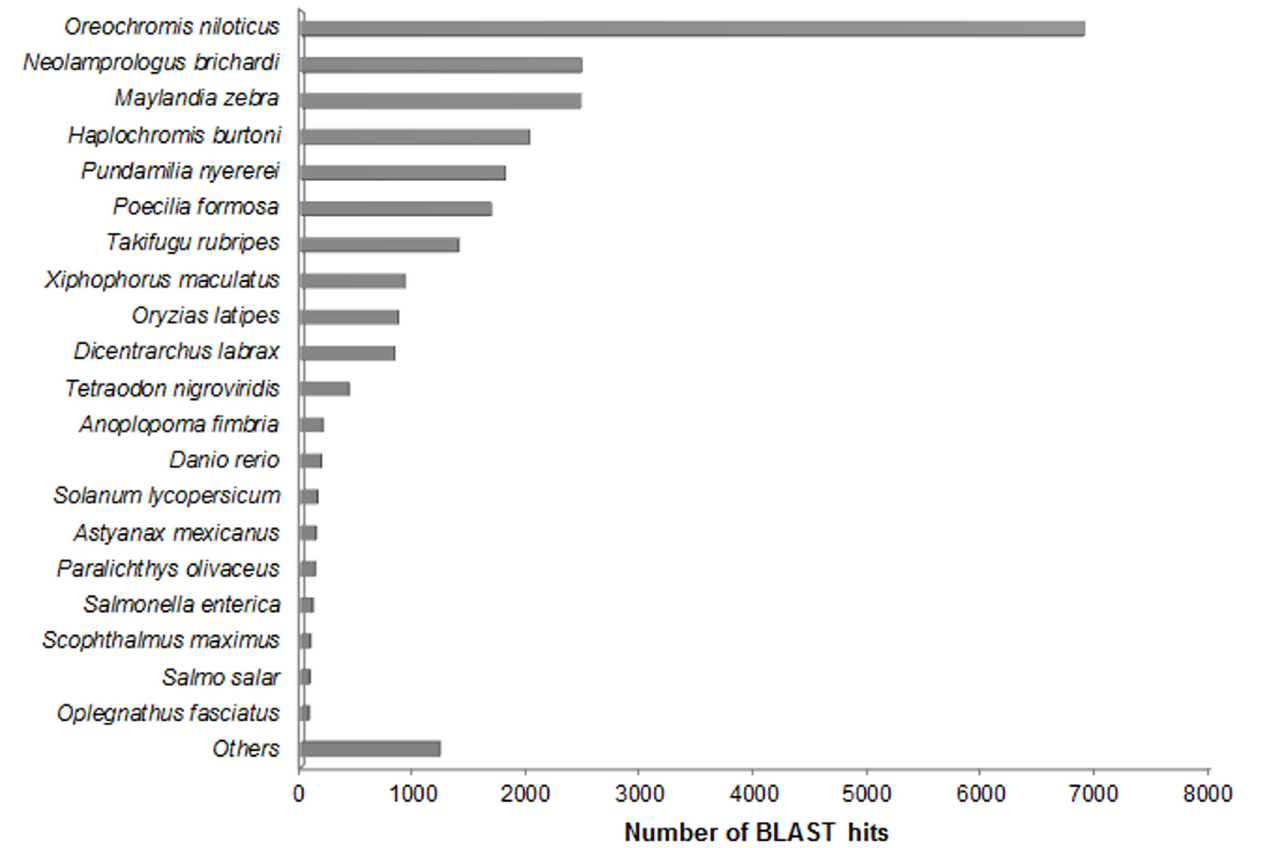
Fig 2. Top 20 hit species distribution based on